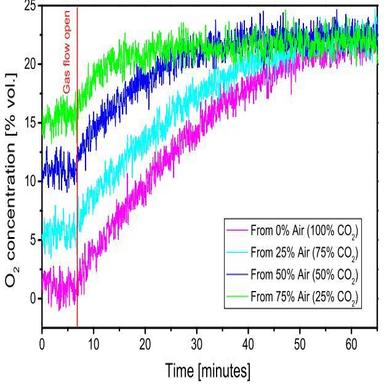
Diffusion of air into the CO2/air mixtures dispersed in polystyrene foam sample.